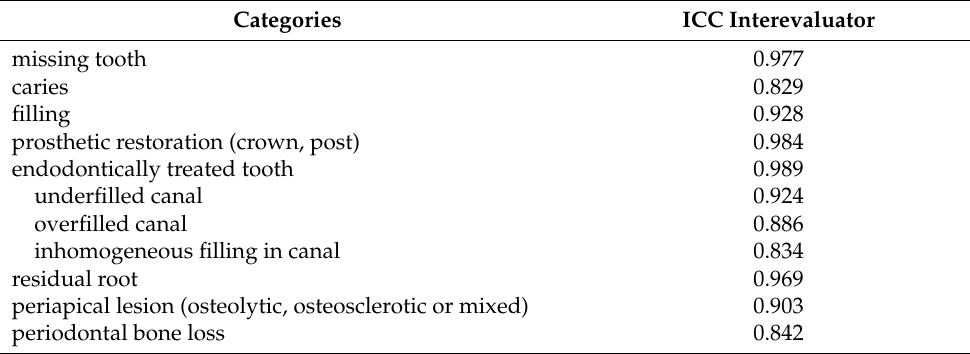
Table 2. ICC for all interevaluator assessments (ICC >075).